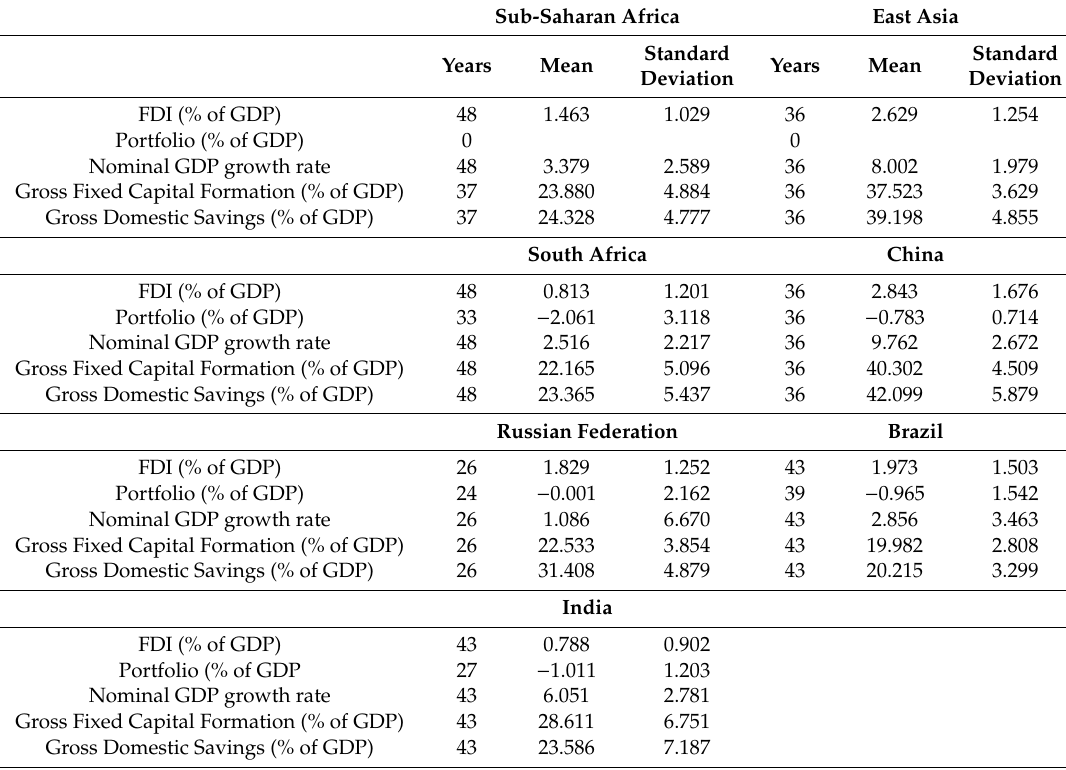
Table 1. Summary statistics (Years: